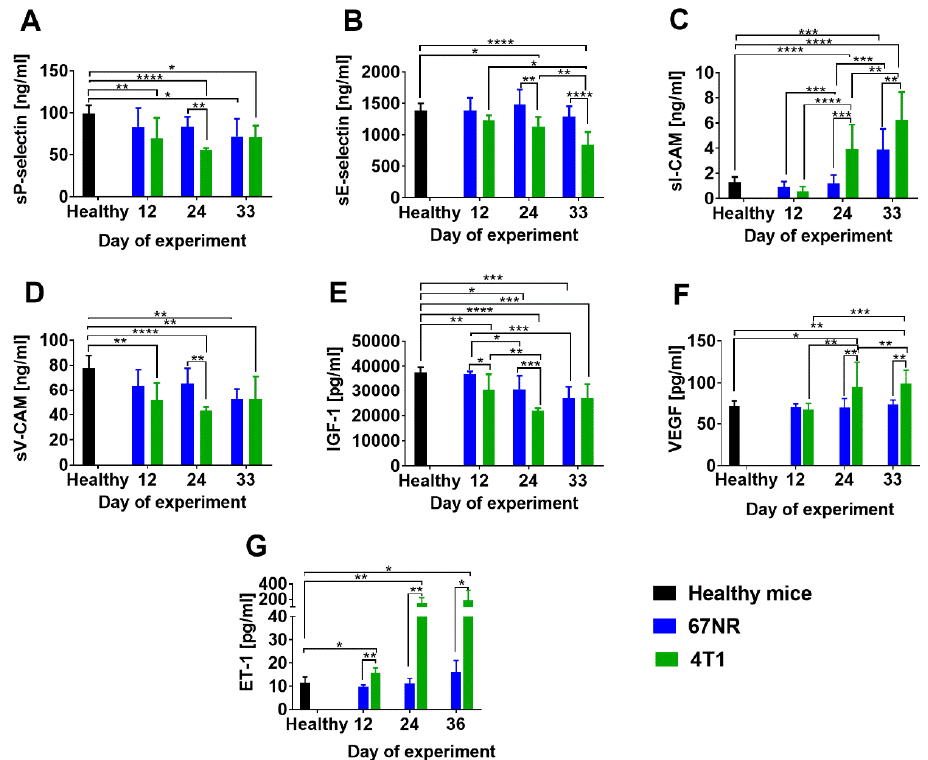
Figure 2. Plasma level of soluble proteins in 6- to 8-week-old mice bearing 67NR tumors compared to 4T1 mouse mammary gland tumors. ( A ) sP- and ( B ) sE-selectin, ( C ) intercellular adhesion molecule (sI-CAM) and ( D ) vascular cell adhesion molecule 1 (sV-CAM), ( E ) insulin-like growth factor 1 (IGF-1), ( F ) vascular endothelial growth factor (VEGF), and ( G ) endothelin-1 (ET-1). Data presented as mean ± SD. Number of mice per group: 5. Statistical analysis: Tukey’s multiple comparison test * p < 0.05, ** p < 0.01, *** p < 0.001, **** p < 0.0001.